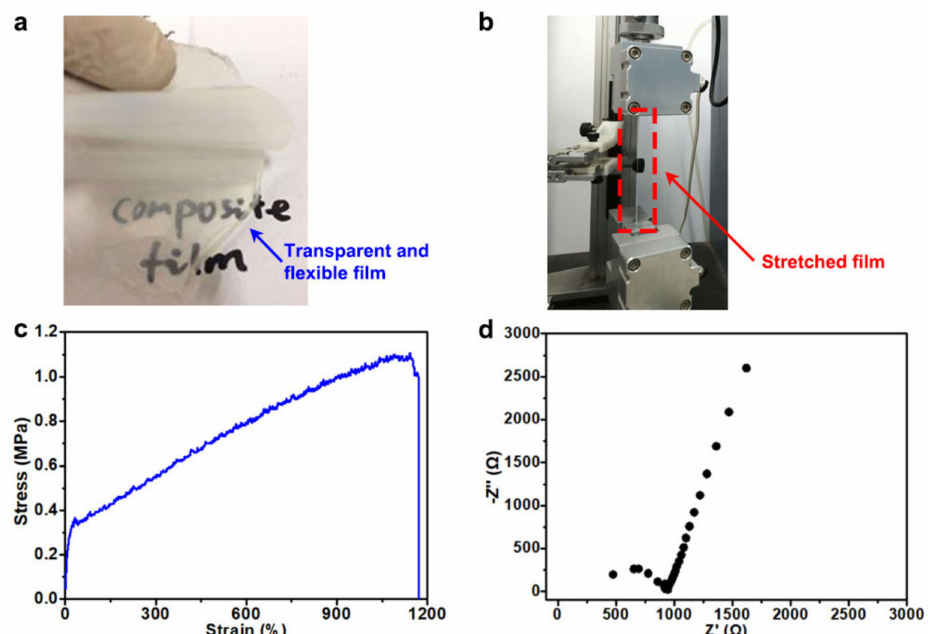
Figure 2. Optical images of a PEO-LiTFSI solid electrolyte film ( a ) without and ( b ) after the tensile measurement; ( c ) tensile stress – strain curve and ( d ) electrochemical impedance spectra at room temperature of the PEO-LiTFSI electrolyte